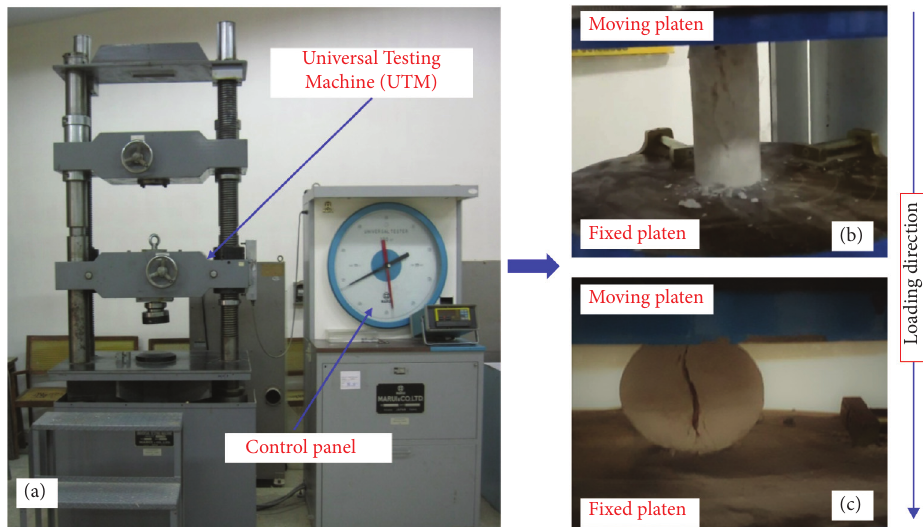
Figure 3: (a) Universal testing machine (UTM), (b) deformed rock core specimen for Brazilian tensile strength test, and (c) deformed rock core specimen for UCS test.